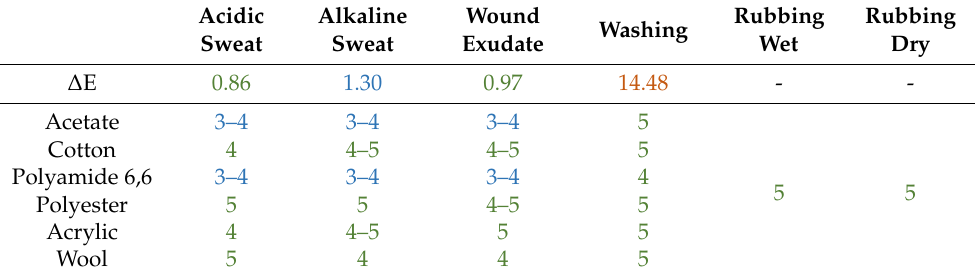
Table 10. Results of the color fastness tests presented as ∆ E variations and assessment of staining using the grey scale (green–not detected color change; blue–low color change detection; orange–strong color change